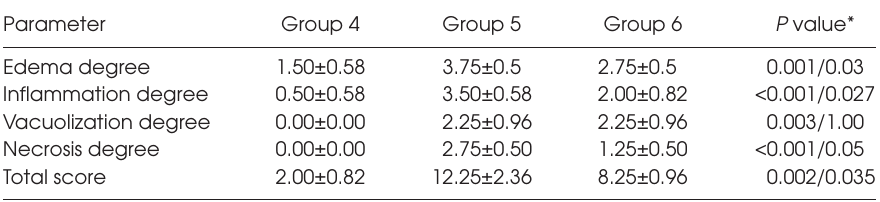
Table 2. Histopathological change of pancreatic tissues in the mice model with acute pancreatitis induced by